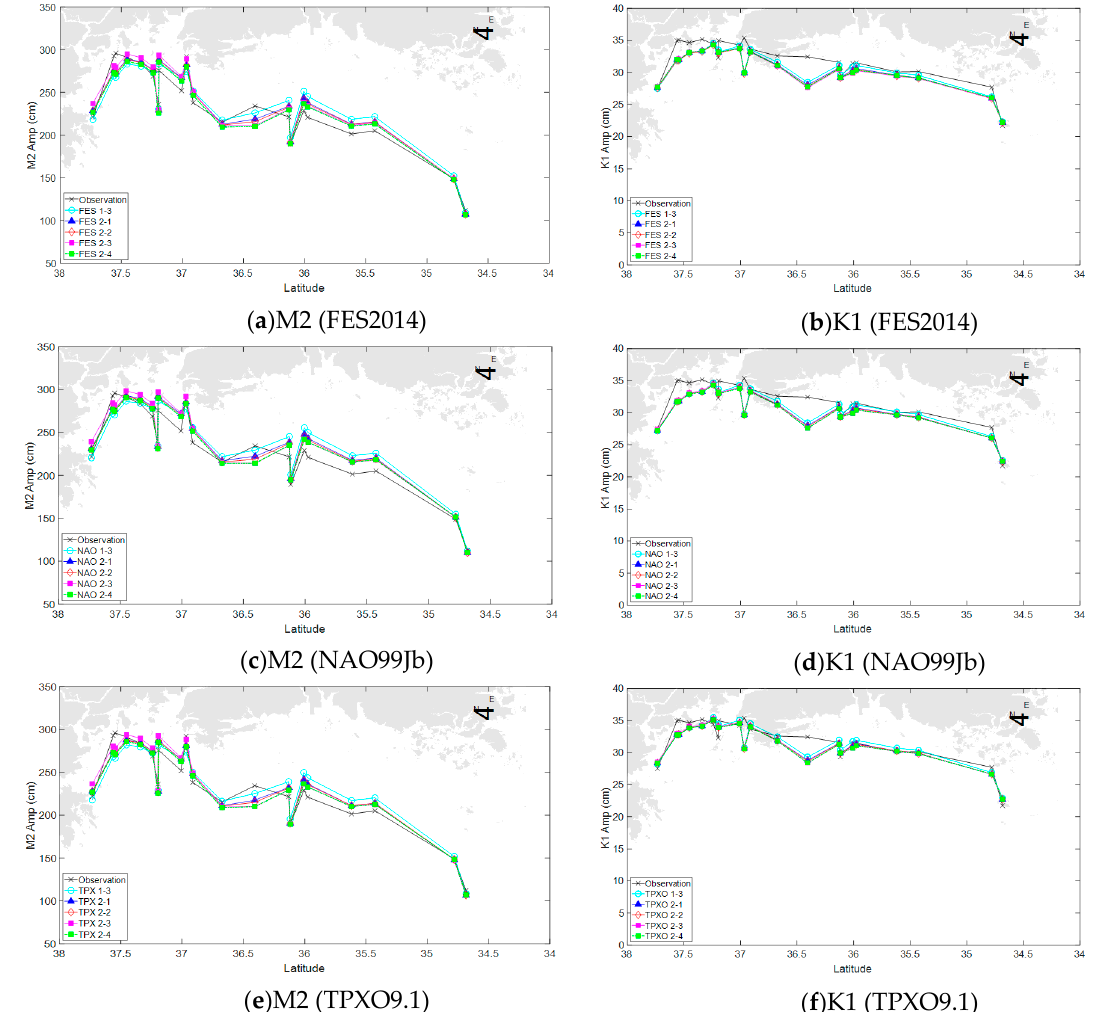
Figure 9. The numerical results of tidal amplitudes M2 and K1 obtained from non-uniform bottom roughness; ( a ), ( c ) and ( e ): M2’s amplitude; ( b ), ( d ) and ( f ): K1’s amplitude.